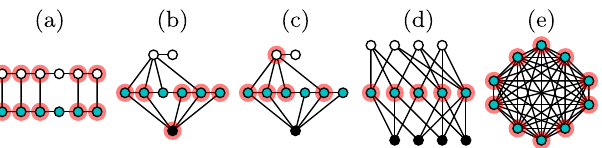
FIG. 6. Variety of color-avoiding components. Color-avoiding components may overlap, as shown in diagrams (b) and (c). Color- avoiding components can assume diverse forms. In a chain (a), paths between nodes of one color exist and can be reached by connections between nodes of different colors. In diagram (b), the black node serves as an alternative path provider for the blue nodes. Graph (d) does not need any connection among nodes of the same color, but there is a massive overhead of nodes and connections to achieve color-avoiding connectivity of the blue nodes. Graph (e) shows that a clique is a color-avoiding